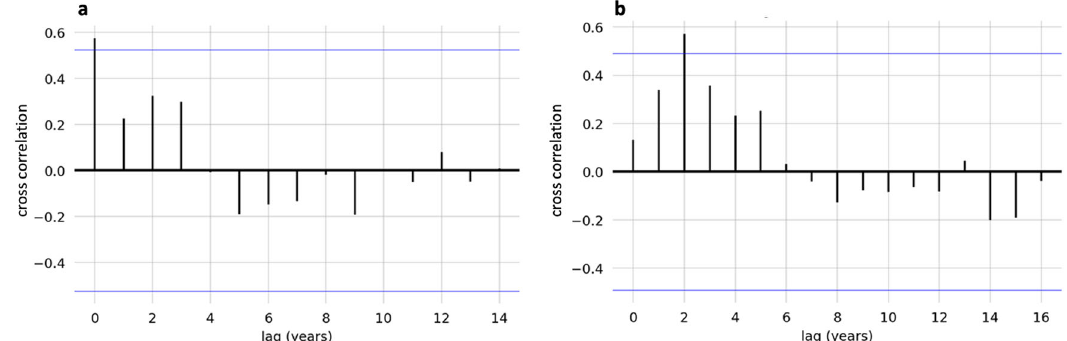
Fig. 3 Cross-correlation between cocaine lyrics and incidence of cocaine use. a Cross correlation for cocaine mentions in lyrics leading cocaine use incidence at different lag times. b Cross correlation for cocaine mentions in lyrics leading cocaine deaths at different lag times. Blue lines indicate the 95% con fi dence interval around cross-correlation value of